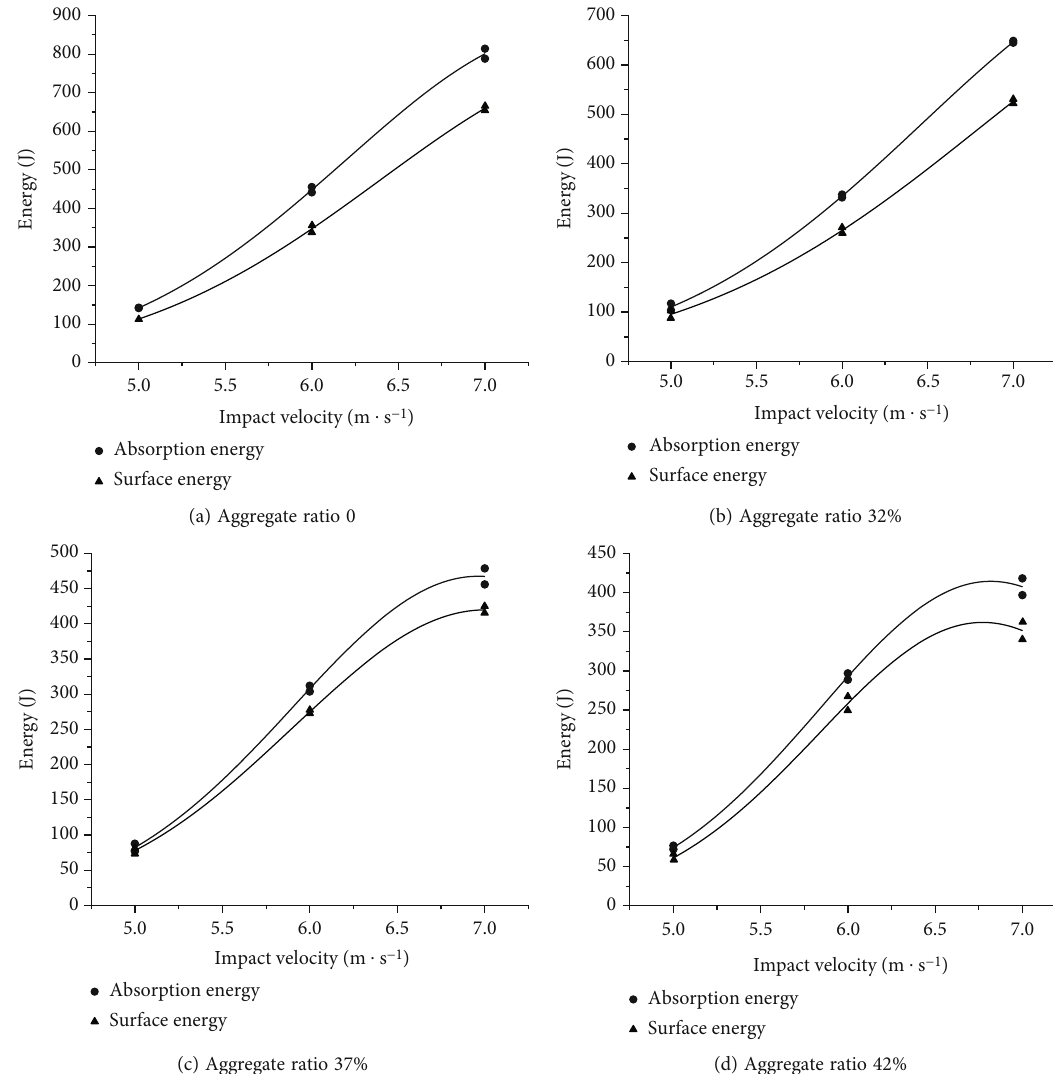
Figure 10: The relationship between the absorbed energy and crack surface energy of the specimens and the impact